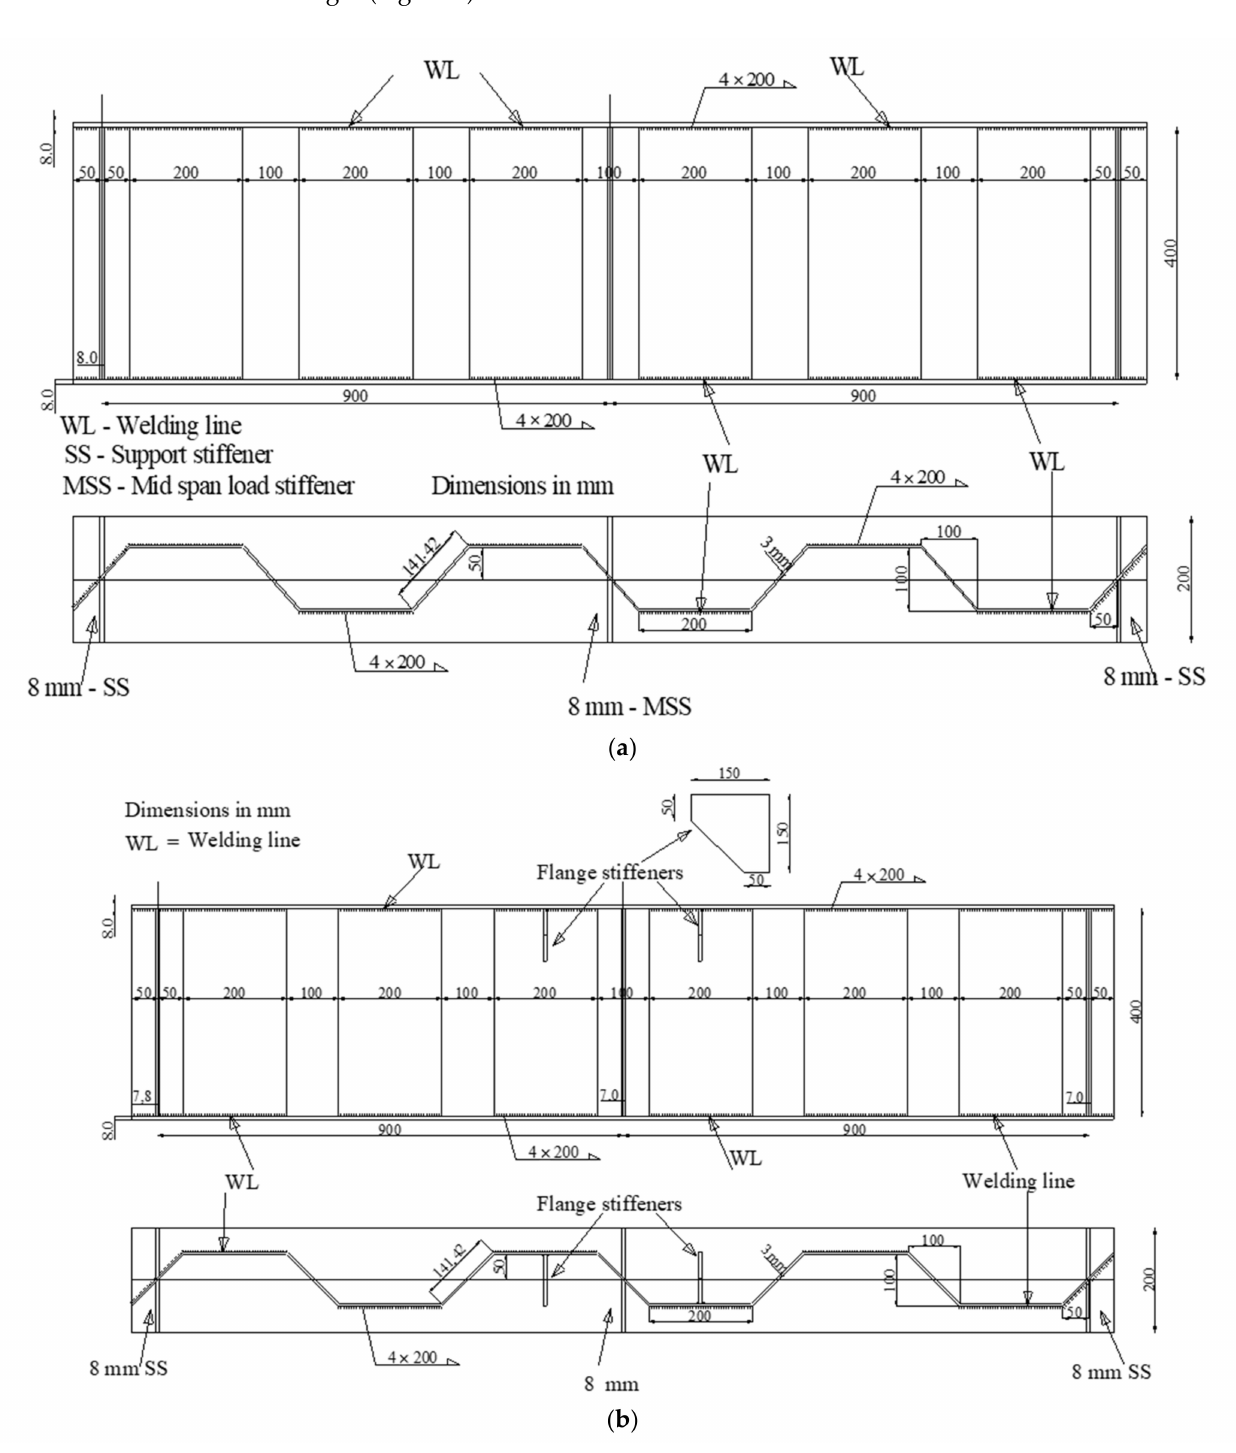
Figure 2. Details of the tested beams with a horizontal fold (HF) length of 200 mm: ( a ) Specimen CW20IFNW; ( b ) Speci- men